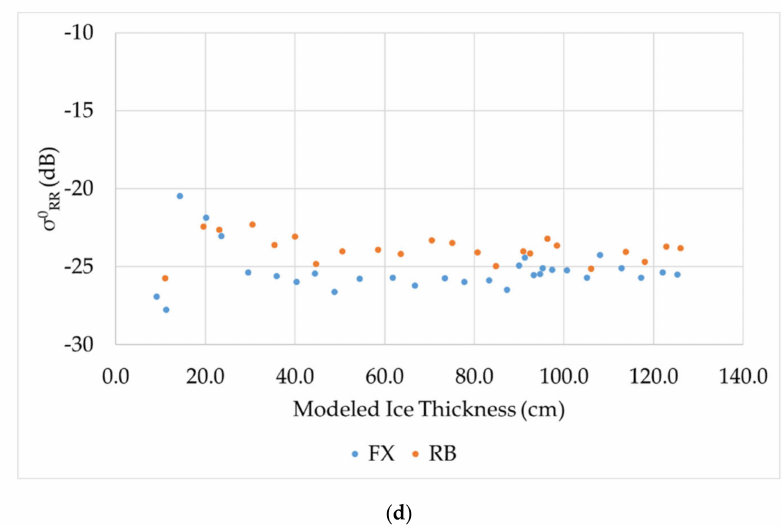
Figure 4. Variation of backscattering coe ffi cients ( a ) σ 0 Red trend line is included for the range when the parameter is sensitive to ice thickness. R is the correlation coe ffi cient of linearly regressed